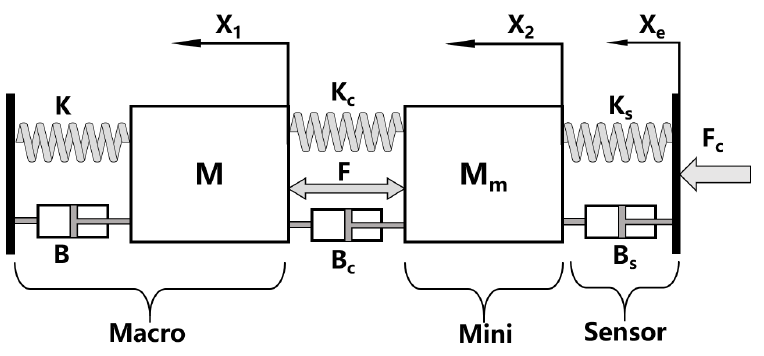
Figure 2. Model of simplified macro-mini manipulator